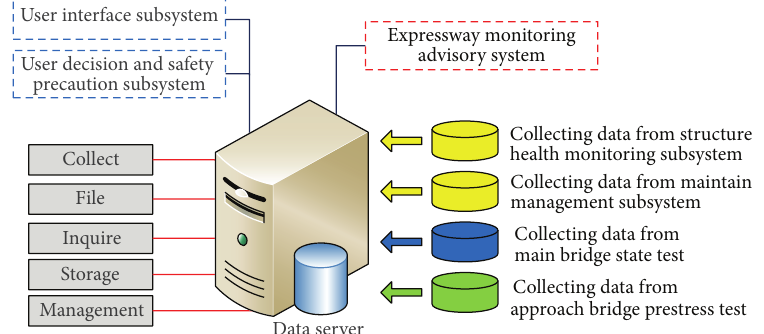
Figure 20: Function and composition of the DMS.